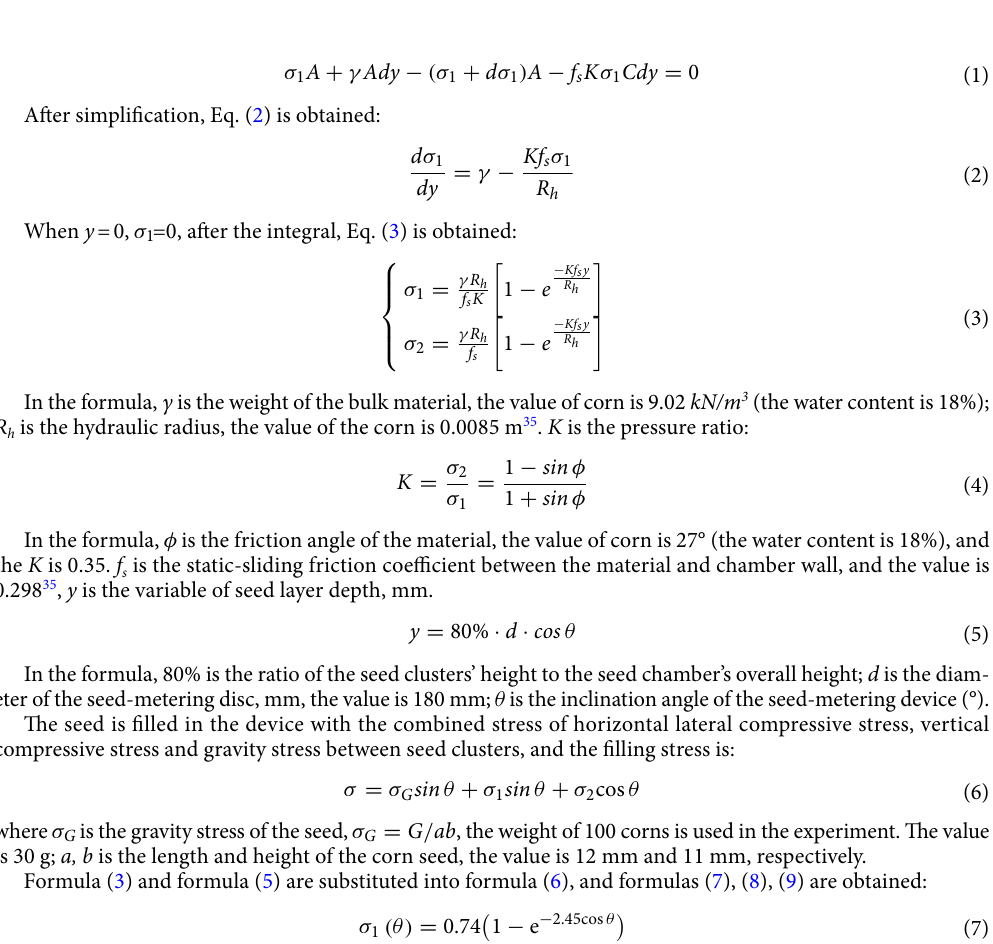
Figure 6. Relational graph about stress with the inclination angle of the metering